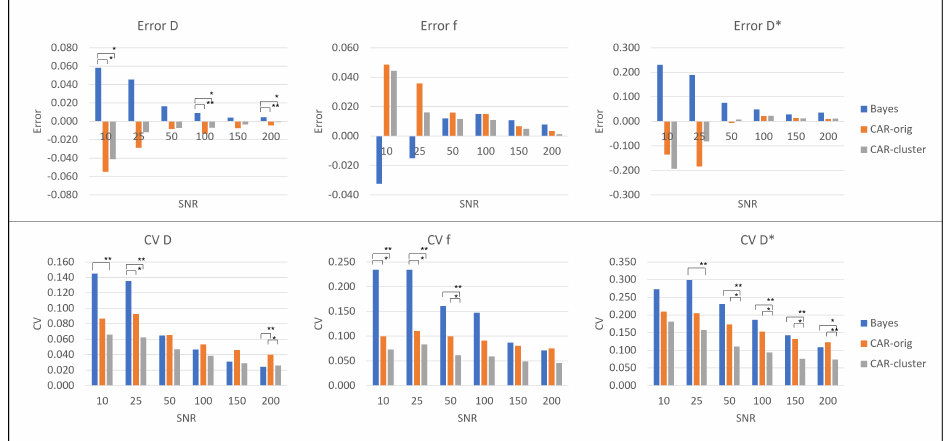
Figure 4. Error ε ( first row ) and CV ( second row ) for the simulated images: values for D ( first col- umn ), f ( second column ) and D ∗ ( third column ). Significant differences are indicated by * ( p < 0.05) and ** ( p < 0.001).